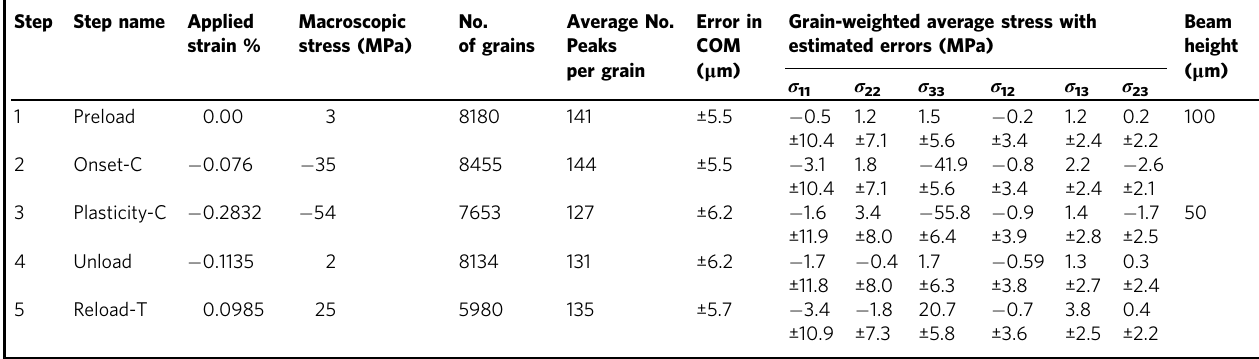
Table 1 Results of 3D-XRD experiment on